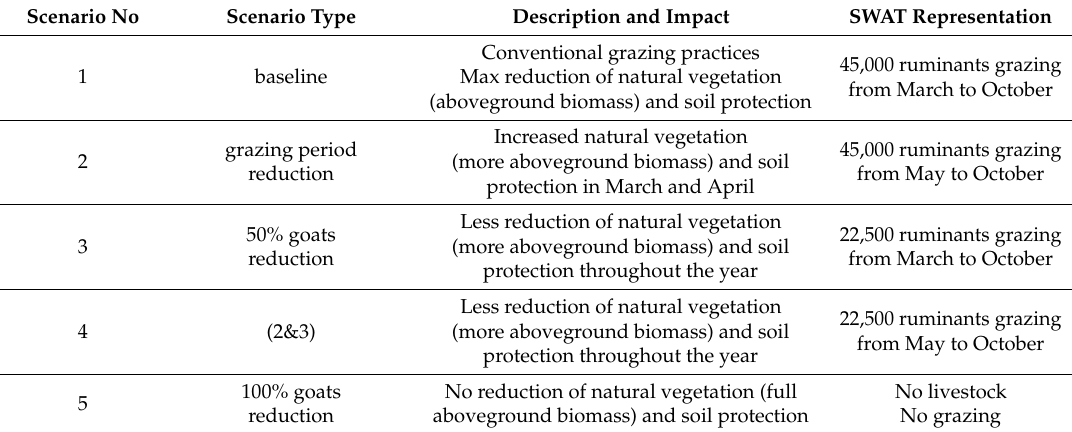
Table 2. List of grazing management scenarios implemented in